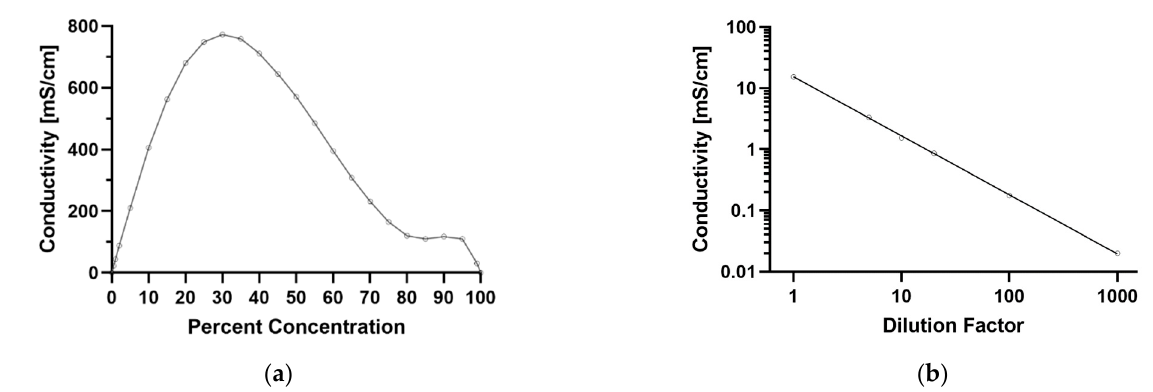
Figure 8. ( a ) Conductivity of concentrated sulfuric acid solution at 21 °C, at different concentrations. The conductivity of the liquid concentrated sulfuric acid (70–100%) in the clouds of Venus is in the range of 100 mS/cm, much higher than conductivities usually used in the DEP microbial capture methods. Such high conductivity poses a challenge for the DEP capture technique. Conductivity values for concentrated sulfuric acid solutions calculated based on values from [47,48]. ( b ) Phosphate buffered saline (PBS) at different dilution factors, diluted with MiliQ water at 21 °C. Diluted PBS (20 µS/cm) is the standard buffer used in FS DEP microbial capture, concentration and separation [17].